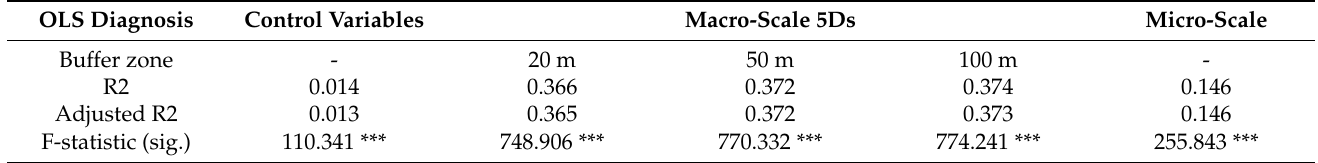
Table 2. The relative importance of control, macro-scale, and micro-scale